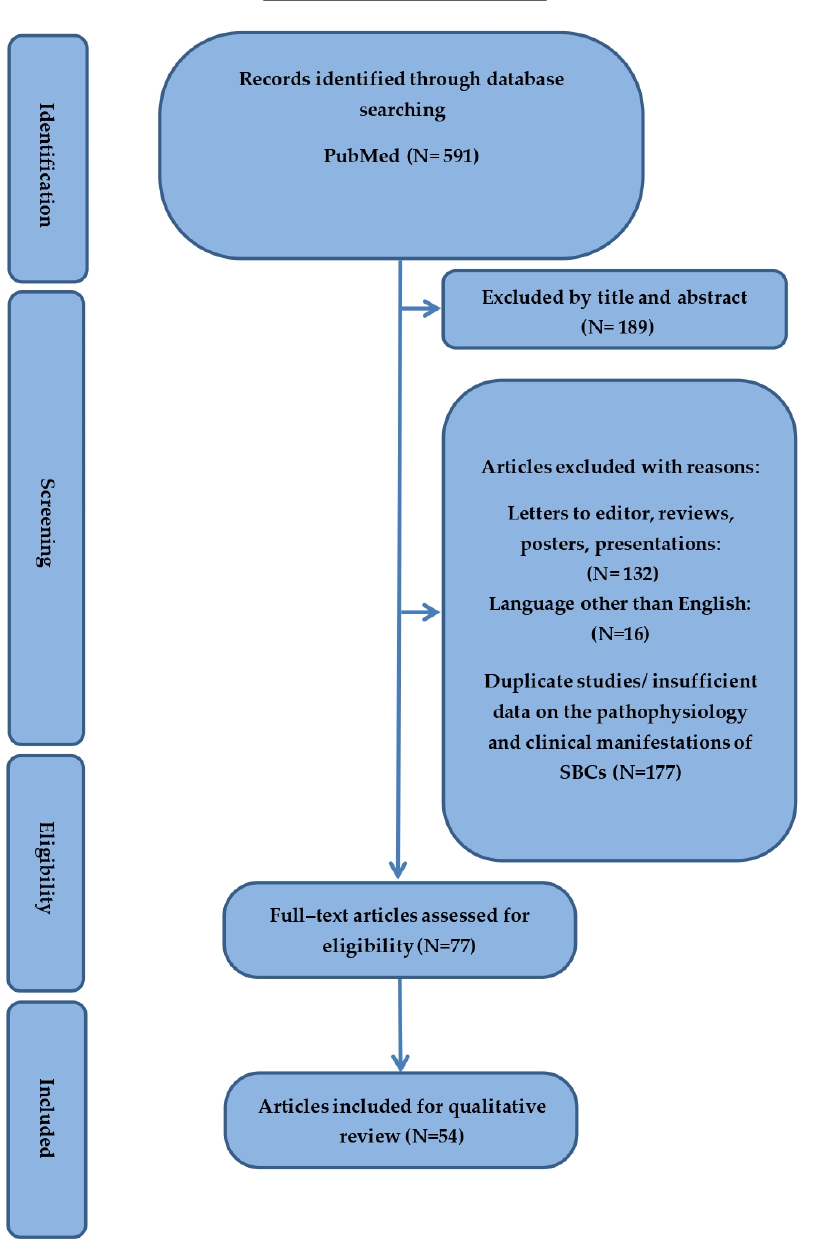
Figure 1. PRISMA flow chart